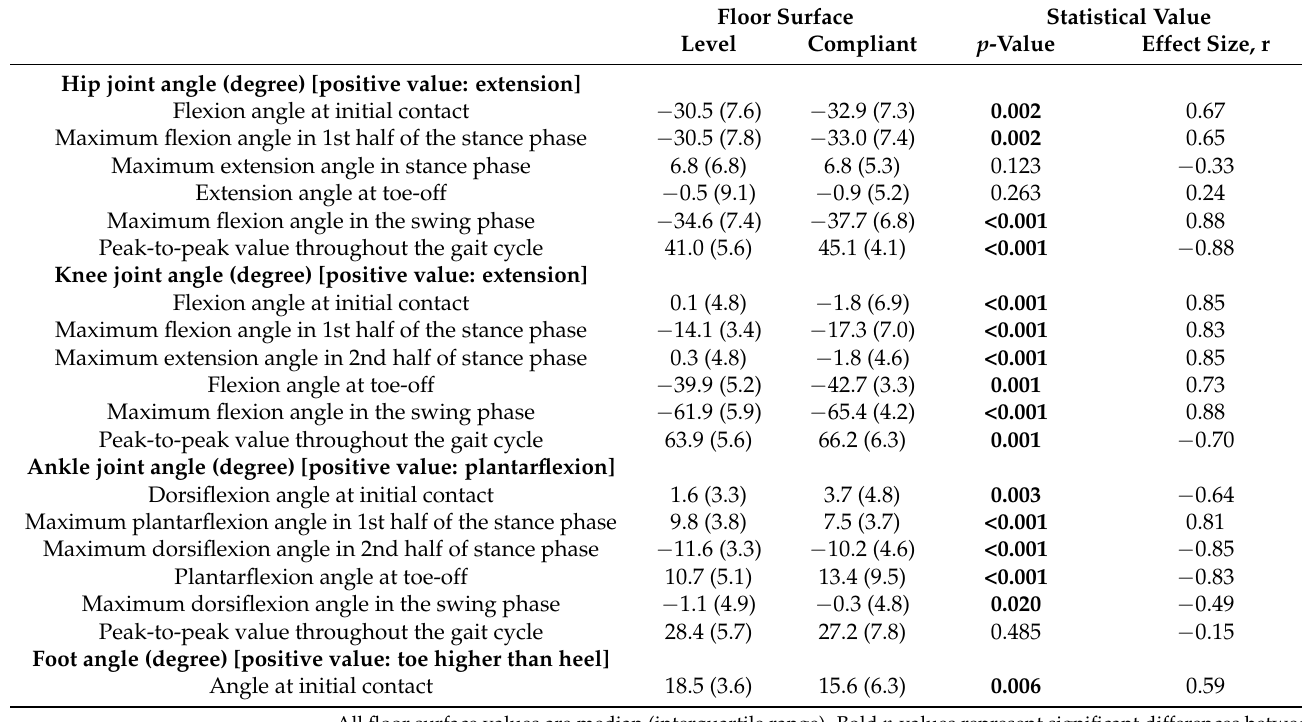
Table 3. Hip, knee, and ankle joint angles during gait on the level and compliant surfaces. Floor Surface